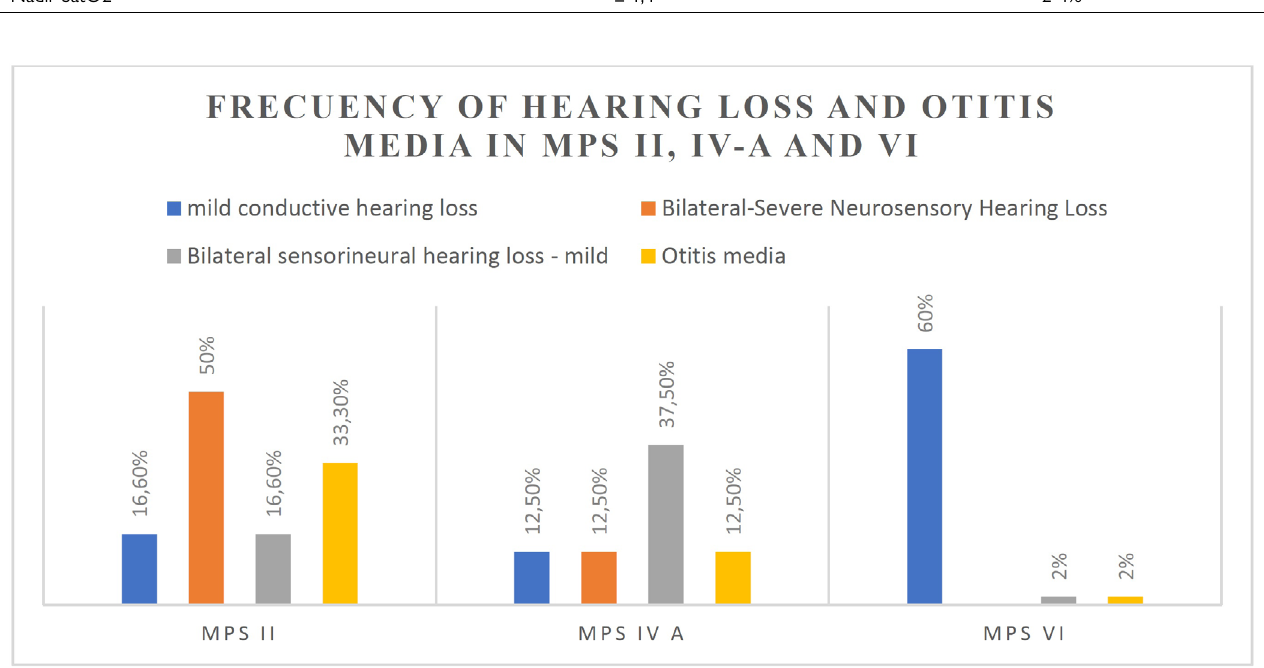
Figure 1. Frequency of Hearing Loss and Otitis Media in MPS II, IV-A and VI. The high frequency of Bilateral –Severe Neurosensory Hearing Loss in patients with MPS I, and the incidence of Mild Conductive hearing loss in patients with MPS.